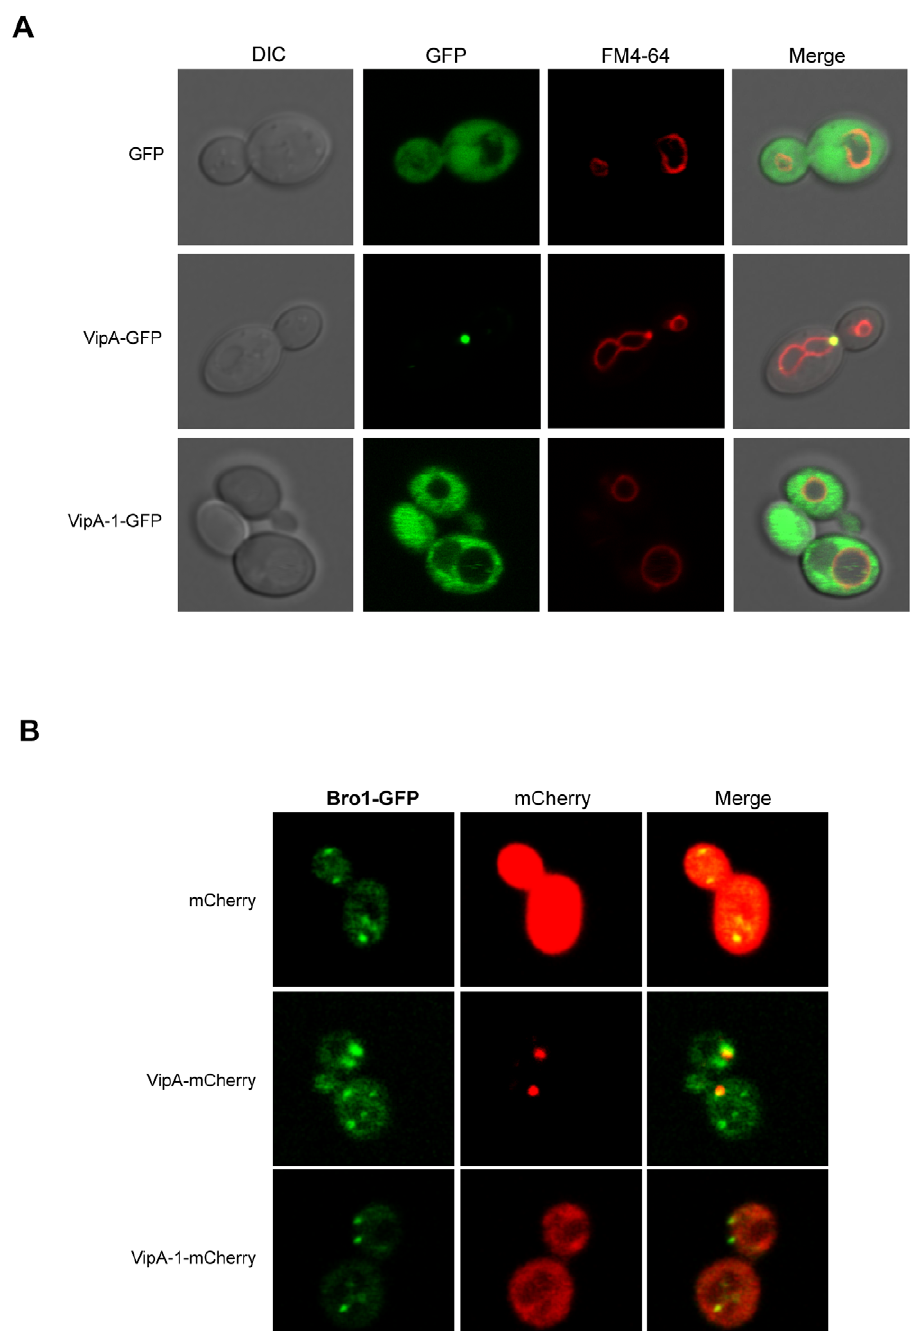
Figure 5. VipA associates with components of the yeast MVB pathway. A. For vacuole staining, S. cerevisiae strains were grown as above (see legend of Figure 4), harvested and additionally pulse-chased with N-(3-triethylammoniumpropyl)-4-(p-diethylaminophenylhexatrienyl)- pyridinium dibromide (FM4-64). B. Strains carrying the fusions Bro1-GFP (left) and mCherry, VipA-mCherry or VipA-1-mCherry were grown and visualized as